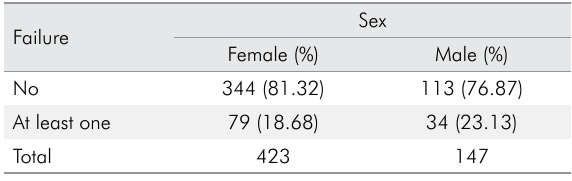
Table 2. Miniscrews failure according to sex.